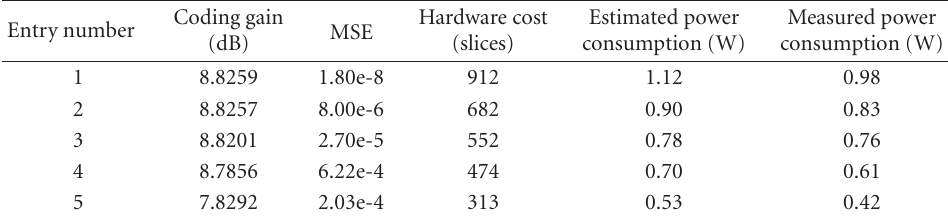
Table 2: Coding gain, coe ffi cient complexity, MSE, and power consumption results for DCT approximations based on Loe ffl er’s factorization using the lifting structure implemented on the XCV300-6 FPGA with a clock rate of